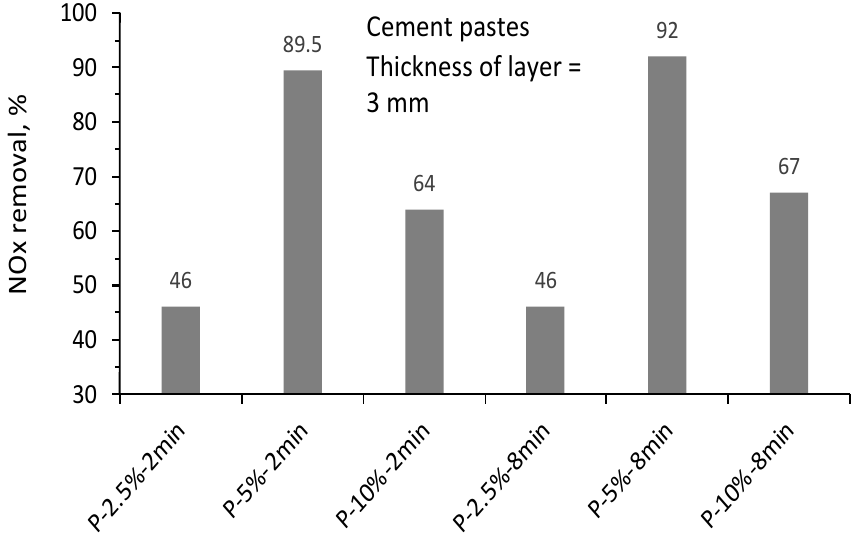
Figure 12. NOx removal (photocatalytic activity) for various TiO 2 concentrations of 2.5%, 5%, and 10% and two dispersion durations (i.e., 2 and 8